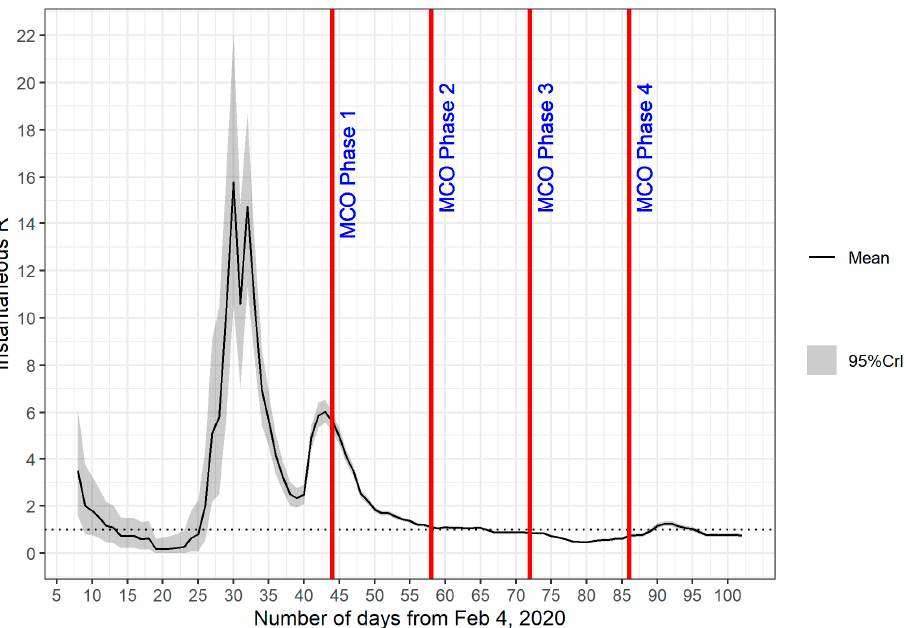
Figure 3. Rt from day 1 (4 February 2020) to day 102 (16 May 2020) on sliding weekly windows. The estimate was based on the serial interval with mean = 7.5 days and SD = 3.4 days.